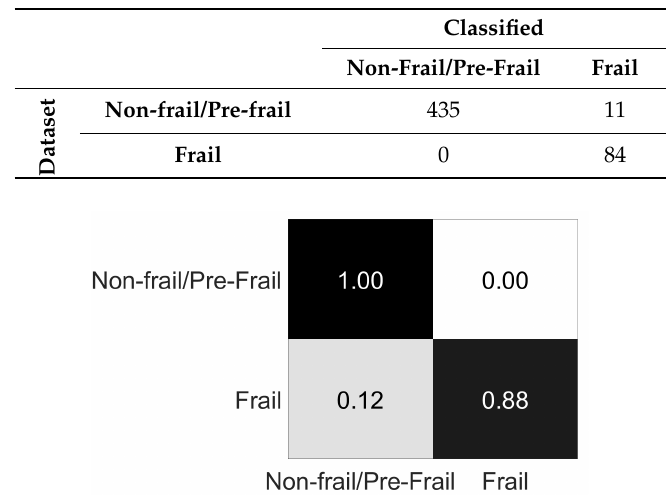
Table 7. Confusion matrix for the RF classifier for the identification of frail subjects problem.